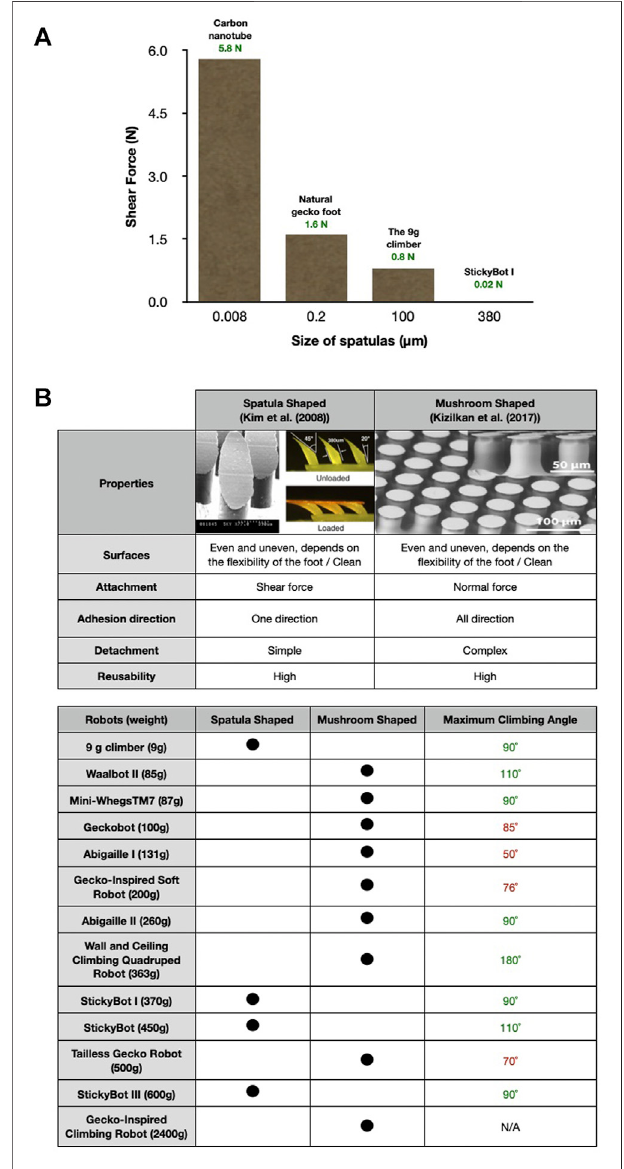
FIGURE 2 | (A) The comparison of shear forces between each spatula sizeofthecarbon-nanotube-basedsyntheticgeckotapes,naturalgeckofoot, StickyBot I, and the 9 g climber in a 0.16 cm 2 area [Ge et al. (2007); Santos et al. (2008); Hawkes et al. (2015)] (B) Characteristics of adhesive materials with spatula-shaped and mushroom-shaped